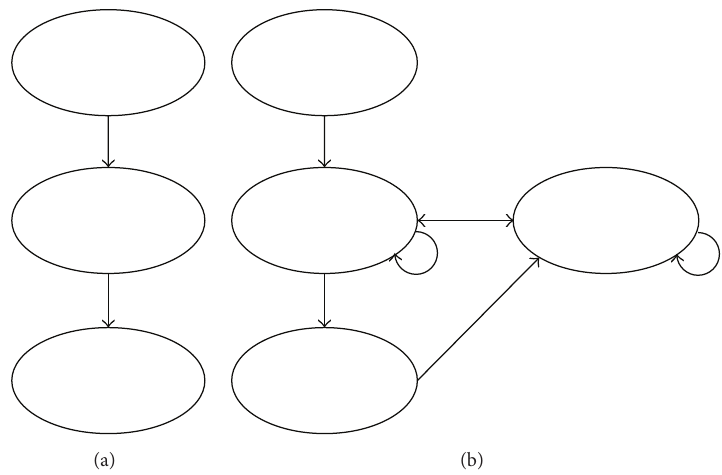
Figure 1: Structural difference between (a) a hierarchy and (b) a network, Chang et al.